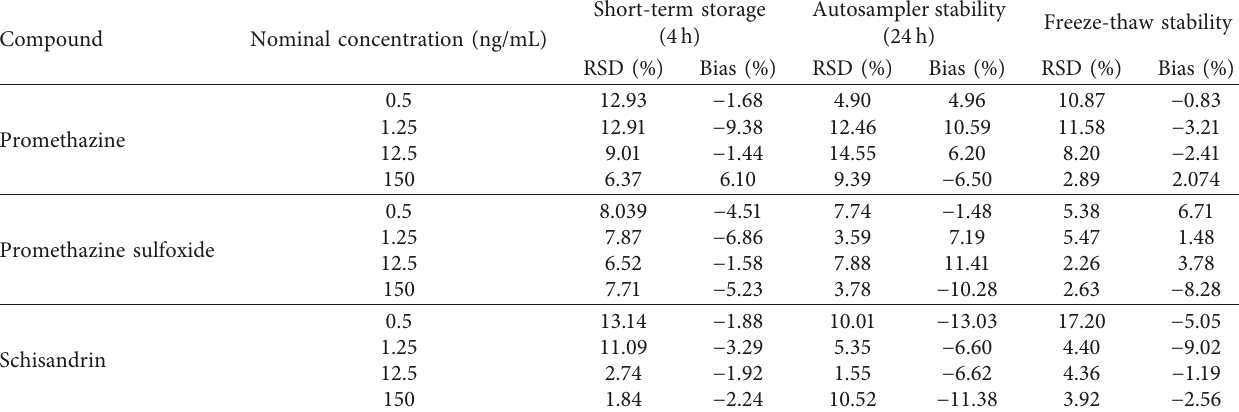
Table 5: Stability of the analytes in rat plasma under different storage conditions.